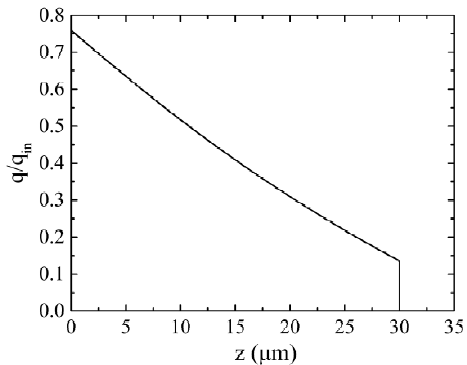
Figure 4. The ratio of laser energy flux through the powder bed to incident heat flux versus the distance z from the top surface for a layer of 30 μm on a solid substrate.